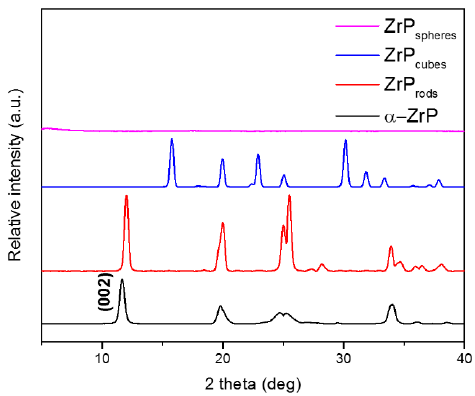
Figure 11. XRPD patterns of α -ZrP, rod-like ZrP, cube-like ZrP, and spherical ZrP. [89]—Reproduced by permission from The Royal Society of Chemistry.